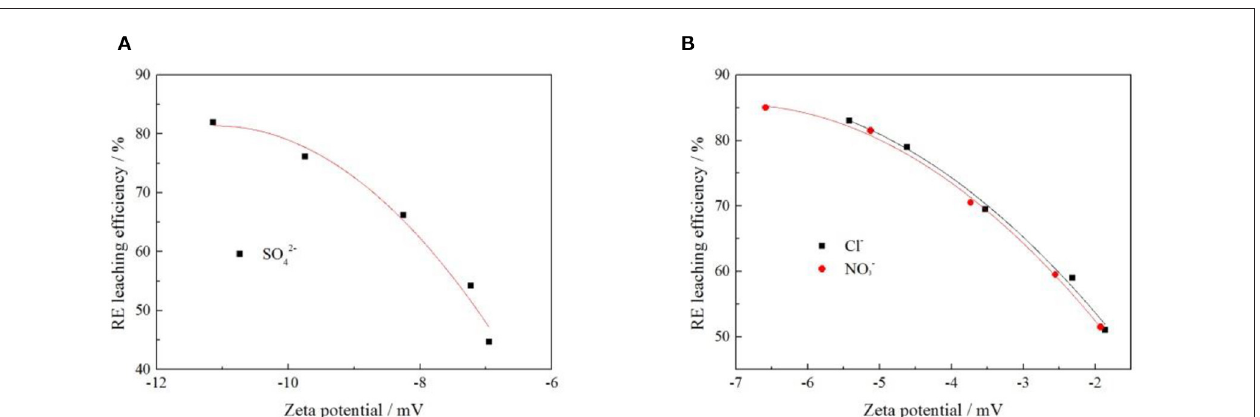
FIGURE 11 | Fitting of zeta potential and leaching efficiency under different anion [where (A,B) represent − 2 and − 1 valence anions, respectively].